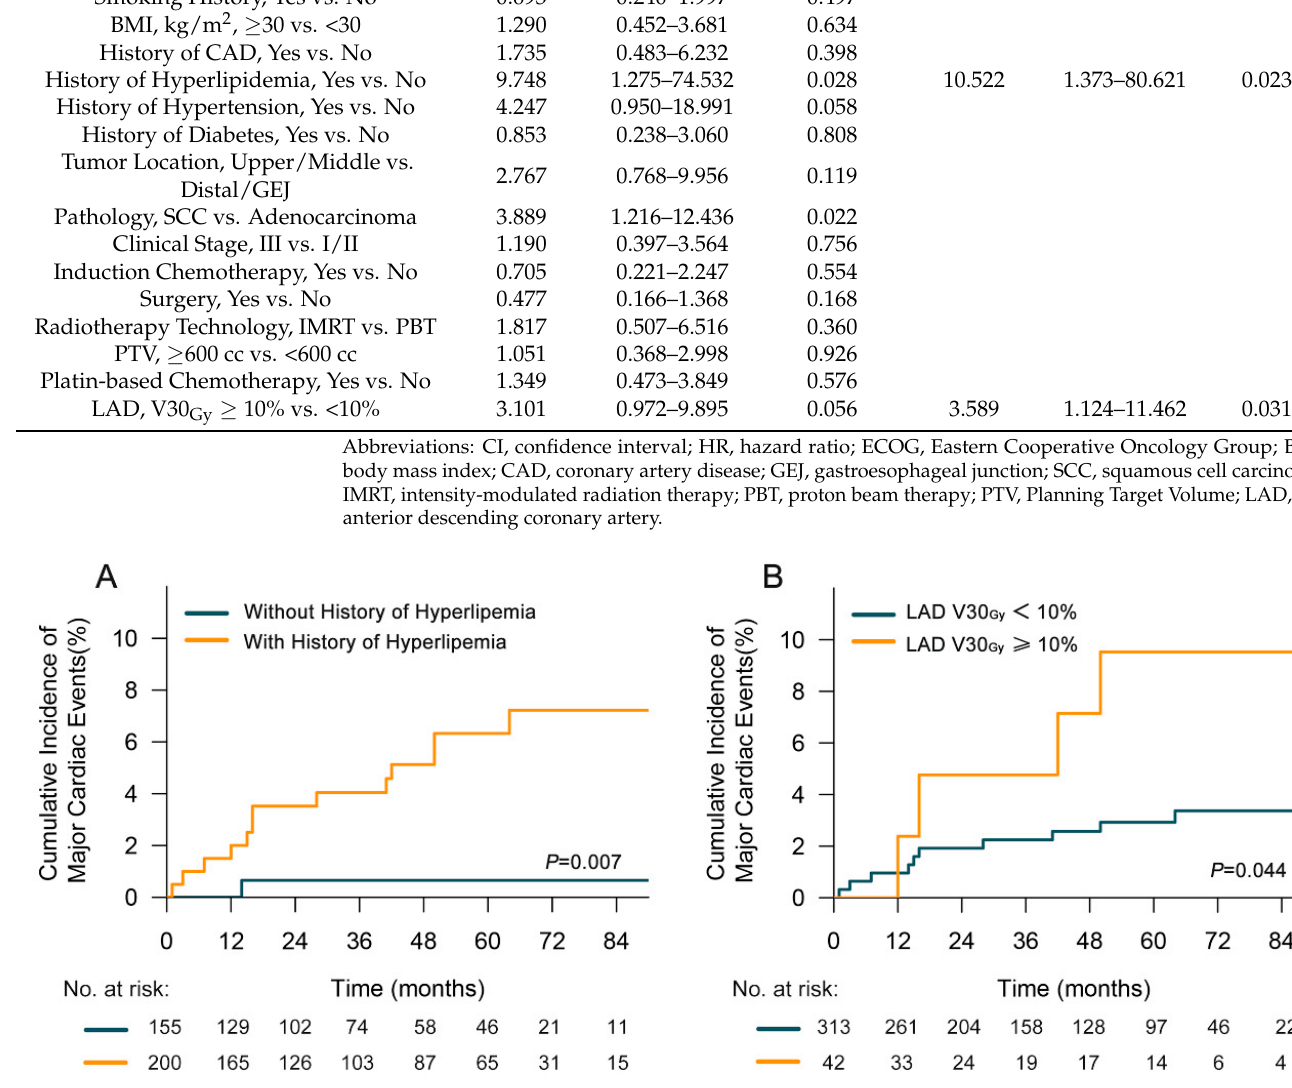
Figure 2. Cumulative incidence of major coronary events (with non-cardiac death as a competing risk) ( A ) for patients with or without a history of hyperlipidemia ( B ) for patients delivered to left anterior descending coronary artery (LAD) V30 Gy < 10% and ≥ 10%. The median OS was 48 months for the entire group. As indicated by dosimetric analy- sis, the relative rate of death significantly increased with the mean LMA dose (HR = 1.014; 95%CI, 1.005–1.023; p = 0.002) and exhibited better predictive efficacy versus heart V30 Gy and MHD (Supplementary Table S3). The optimal cutoff value of the mean LMA dose was determined to be 20 Gy (C-index,